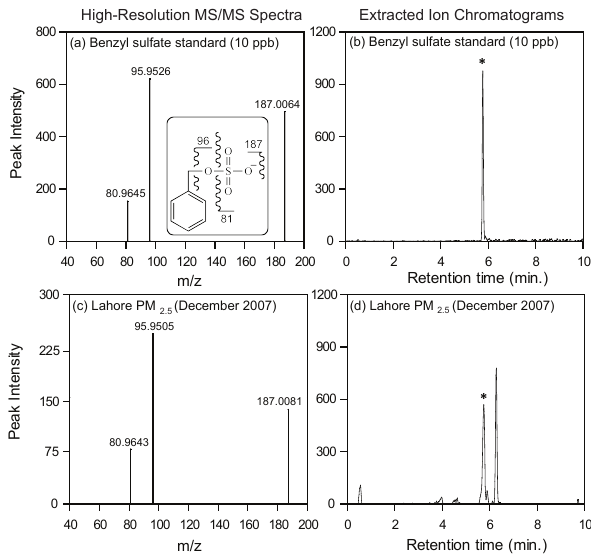
Fig. 1. High resolution product ion mass spectra and extracted ion chromatogram ( m / z 187.01 ± 0.01) of benzyl sulfate in a standard (a, b) and in Lahore, Pakistan, PM 2 . 5 sample collected in December 2007 (c, d) . Chromatographic peaks marked with a star correspond to MS/MS